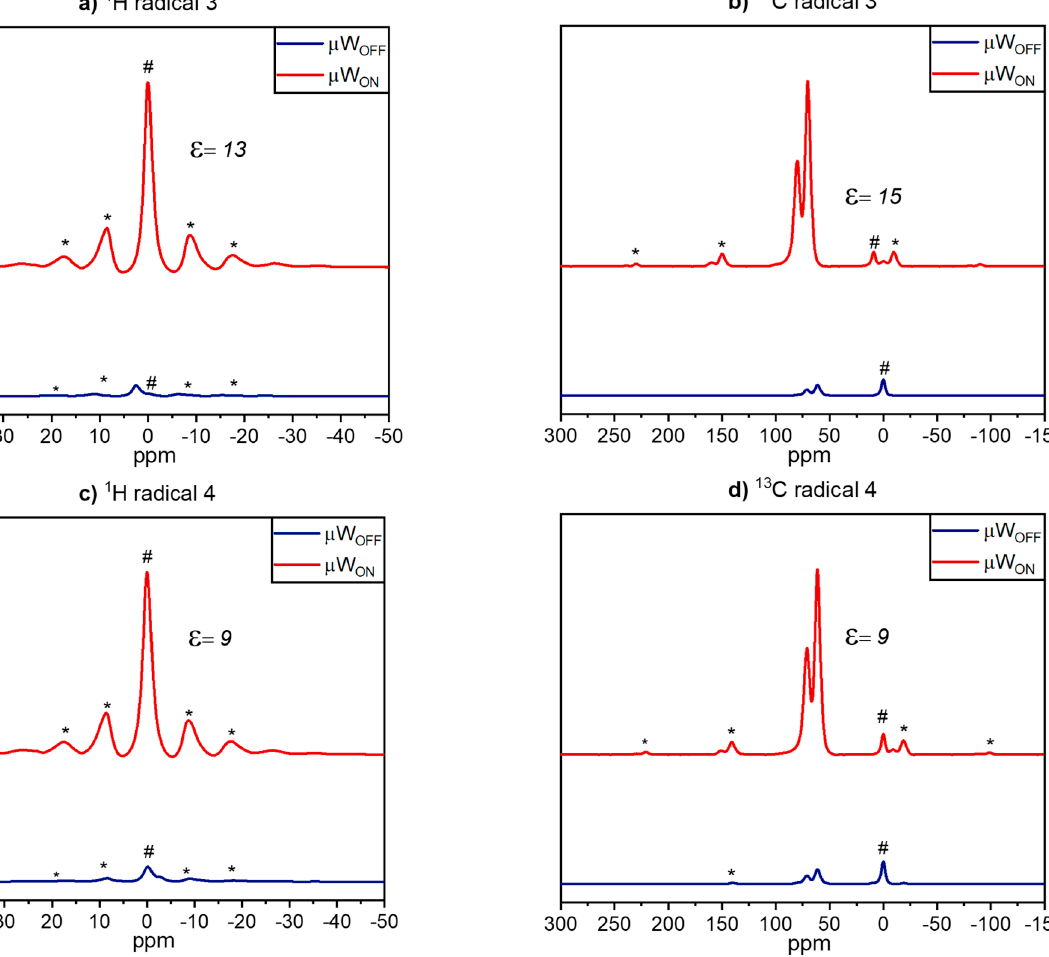
Figure 3. 1 H MAS and 1 H → 13 C CPMAS spectra of frozen solutions of 15 mM binitroxyl radicals 3 ( a , b ) and 4 ( c , d ) in glycerol-d 8 /D 2 O/H 2 O (60:30:10 v/v/v). Spectra were recorded with ( μ W ON ) or without ( μ W OFF ) microwave irradiation at nominally 115 K. The # indicates the signal from the silicon plug near 0 ppm and the asterisks are attributed to spinning sidebands.